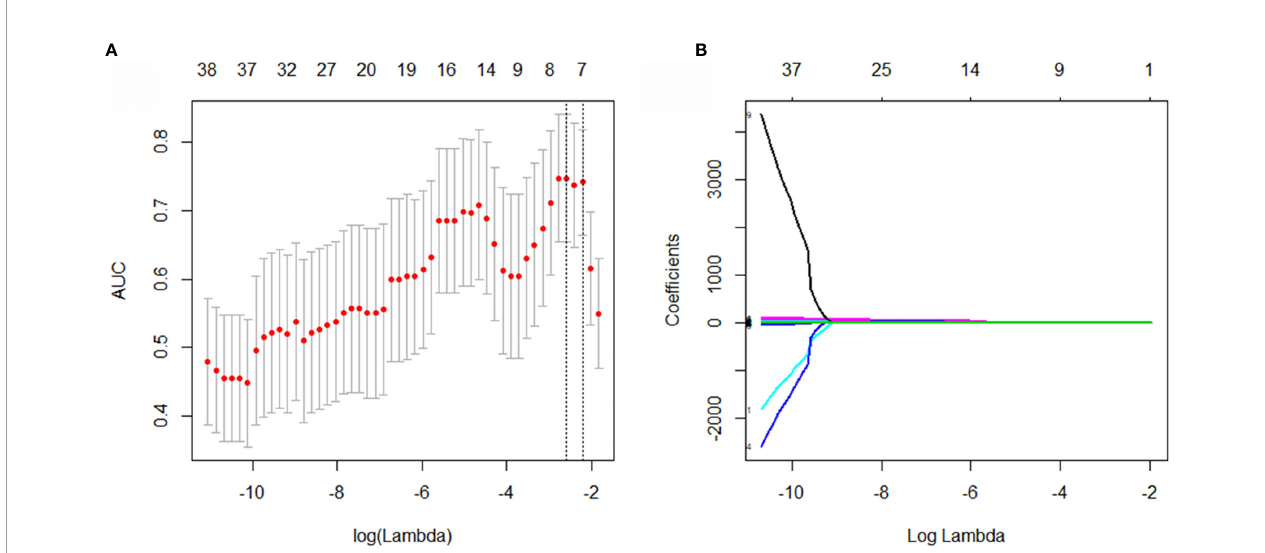
FIGURE 2 | Selection of histological subtypes-associated radiomics features using the elastic net method. (A) Tuning parameter ( l ) in the elastic net used 10-fold cross validation via maximum area under curve and criterion of minimum standard deviation were followed. (B) The coef fi cient pro fi les of 39 radiomics features. A coef fi cient pro fi le plot was generated by violating the log ( l )